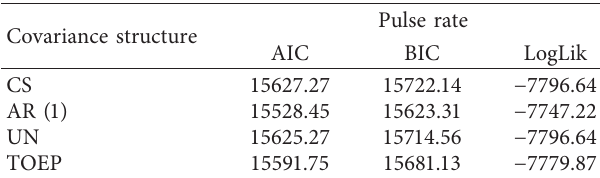
Figure 4: Mean profile plot of the pulse rate for heart failure patients. Table 3: Comparison of the covariance structure of a linear mixed- effect